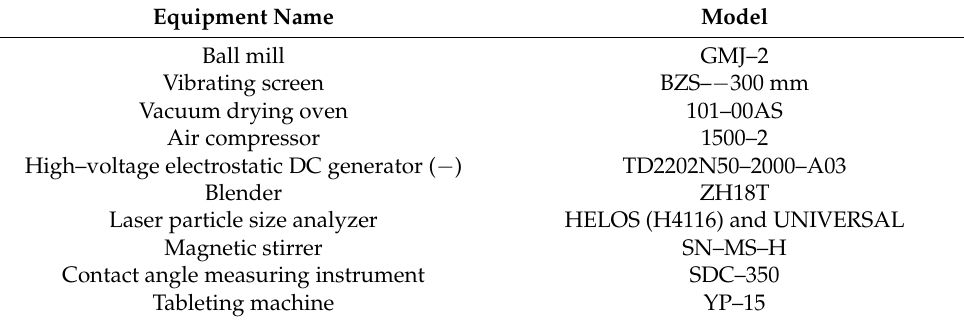
Table 1. Experimental instruments and